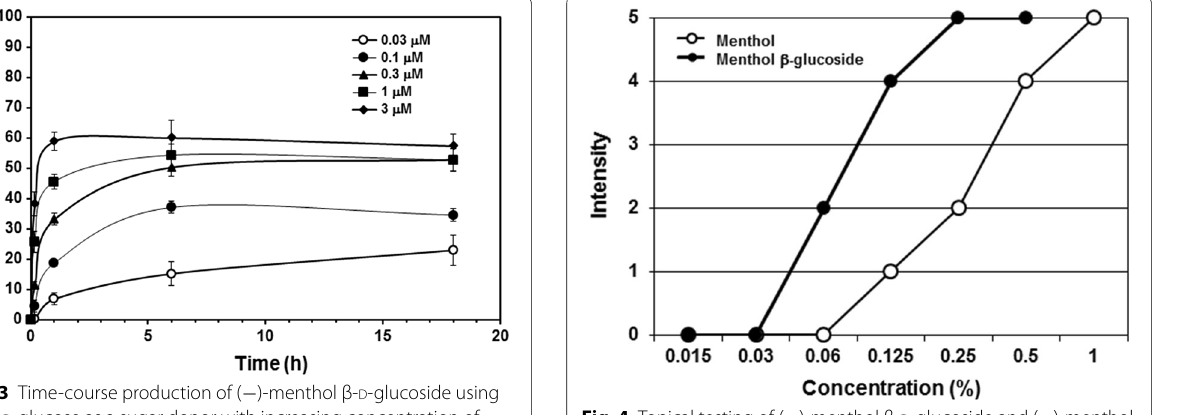
Table 2 1 H- and 13 C-NMR data (700 MHz, CD